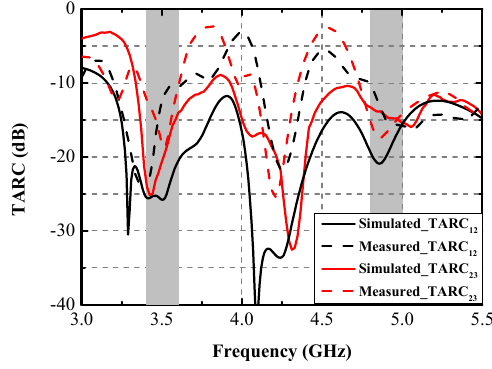
Figure 14. Simulated and measured TARCs.